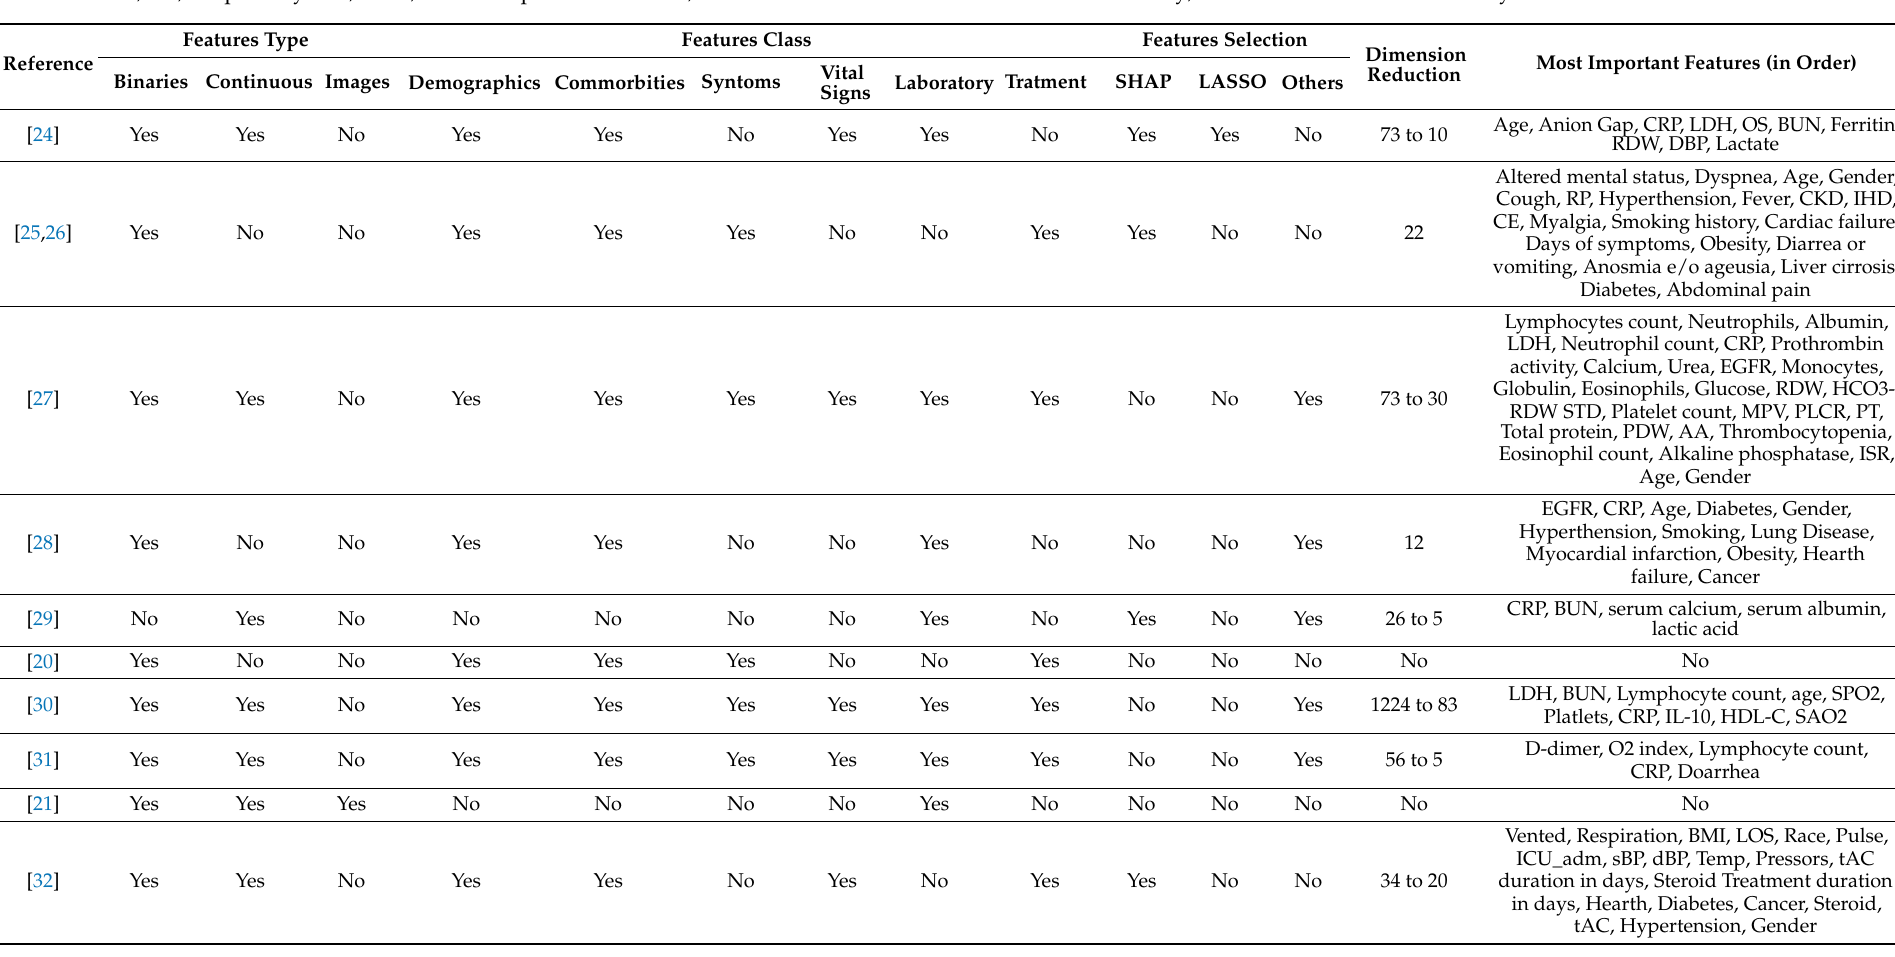
Table 2. Studies Features and Feature Ranking Techniques. Abbreviations: CRP, C-Reactive Protein; LDH, Lactate Dehydrogenase; OS, Oxygen Saturation; BUN, Blood Urea Nitrogen; RDW, Red Cell Distribution Width; DBP, Diastolic Blood Pressure; RP, Respiratory pathology; CKD, Chronic kidney disease; IHD, Ischemic heart disease; CE, Cerebrovascular event; EGFR, Estimated glomerular filtration rate; MPV, Mean platelet volume; PLCR, Platelet large-cell ratio; PT, Prothrombin time; PDW, Platelet distribution width; AA, Aspartate aminotransferase; ISR, International standard ratio; BMI, Body mass index; LOS, Lenght of stay in hospital; sBP, sistolic blood pressure; dBP, diastolic blood pressure; tAC, anticoagulation treatment; RR, Respiratory rate; MCV, Mean Corpuscolar Volume; IL-10: Interleukina—10. Yes if Included the study; No if Not Included in the